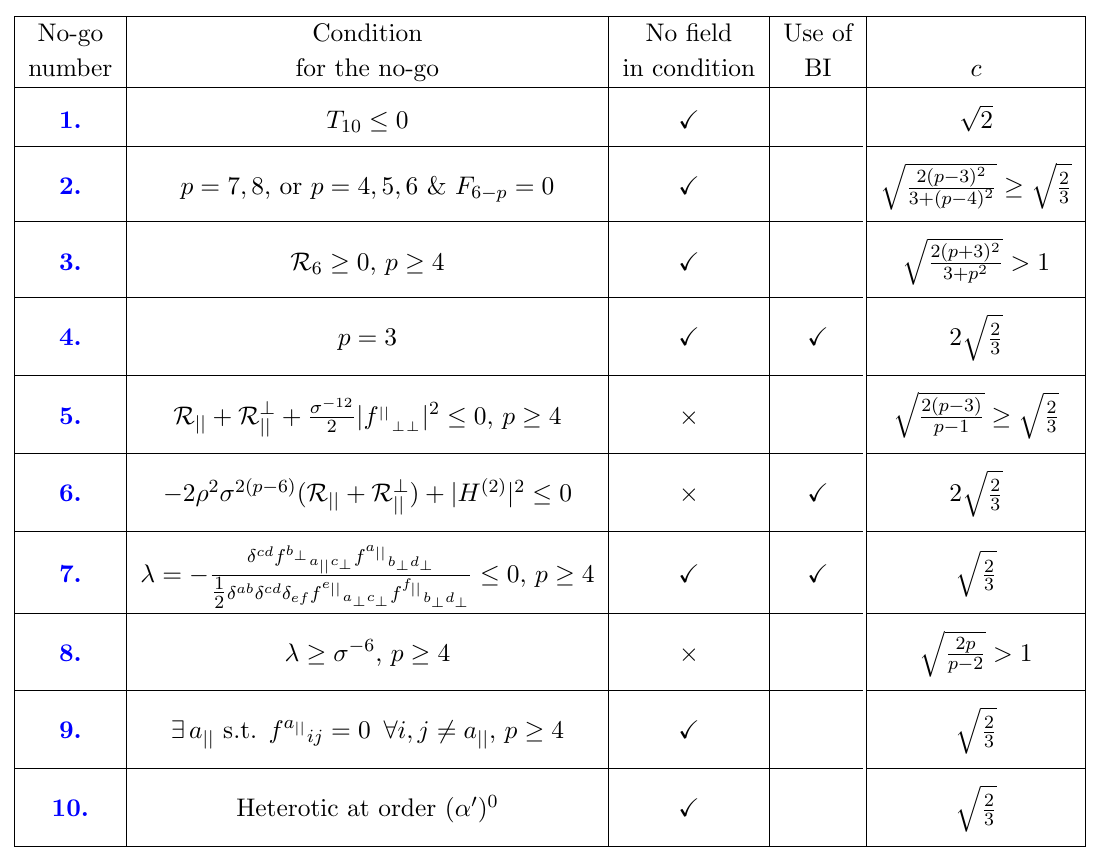
Table 2 . No-go theorems translated into an inequality of the form (1.2) and the corresponding value of c . The various properties speci(cid:12)ed for each no-go theorem are discussed in the text. All no-gos are obtained in type II supergravities except the last